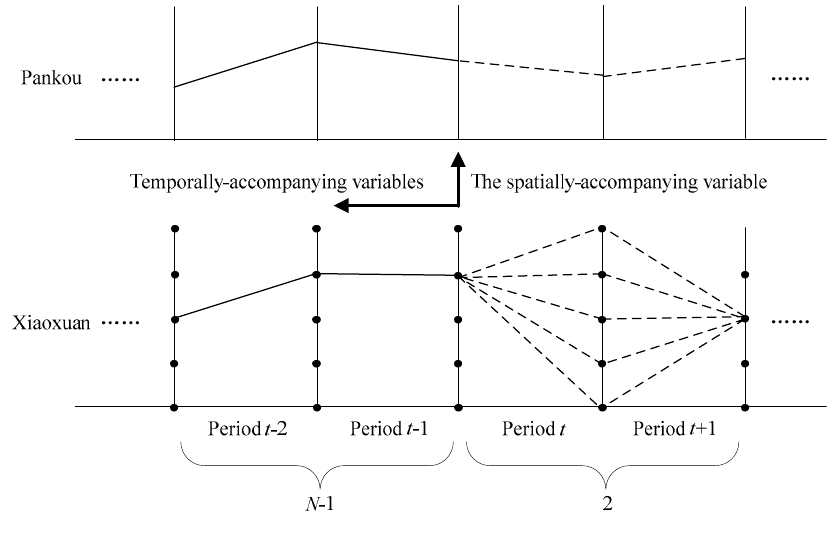
Figure 6. Schematic diagram of APOA.